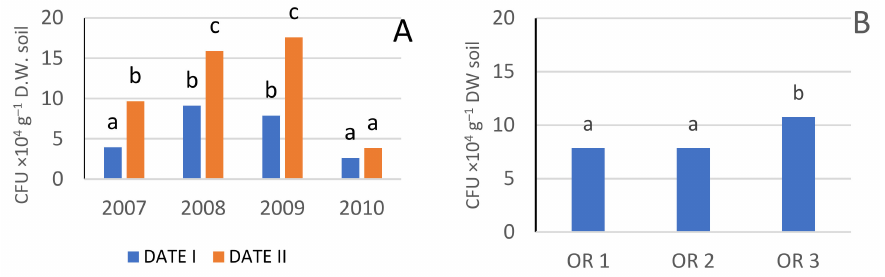
Figure 7. Number of fungi in 2007–2010: ( A )—depending on the year and date of sampling; ( B )—depending on the